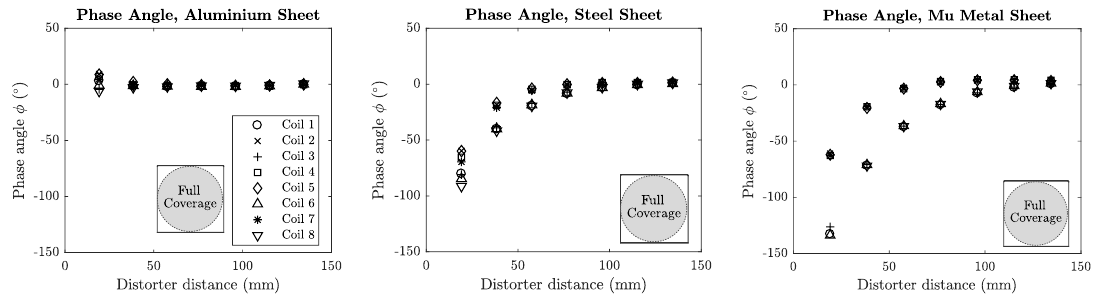
Figure 14. Phase error for the planar sheet distorters. The aluminium sheet contributes a small positive phase shift, while both steel and mu-metal sheets contribute large negative phase shifts when in close proximity to the transmitter.